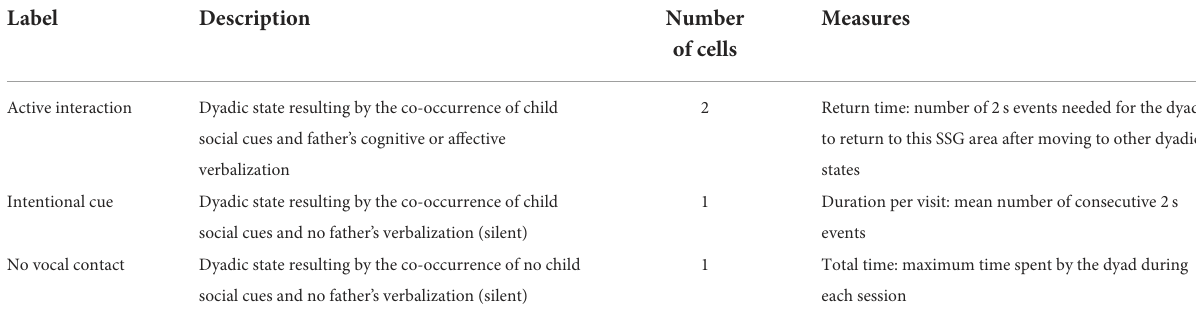
TABLE 3 Content-specific dyadic regions of interest and measures.